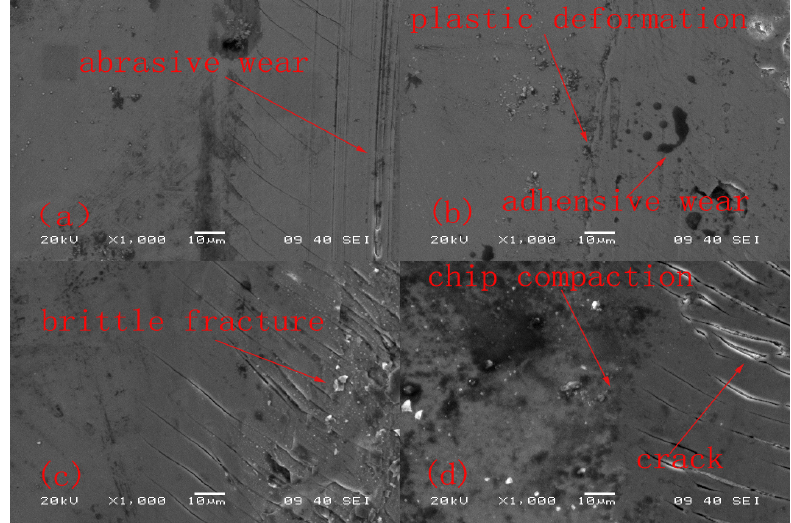
Figure 13. Atomic fraction of O element of the Cr 38.7 Ti 3.7 B 6.4 N 51.2 film after wear test at different temperature.